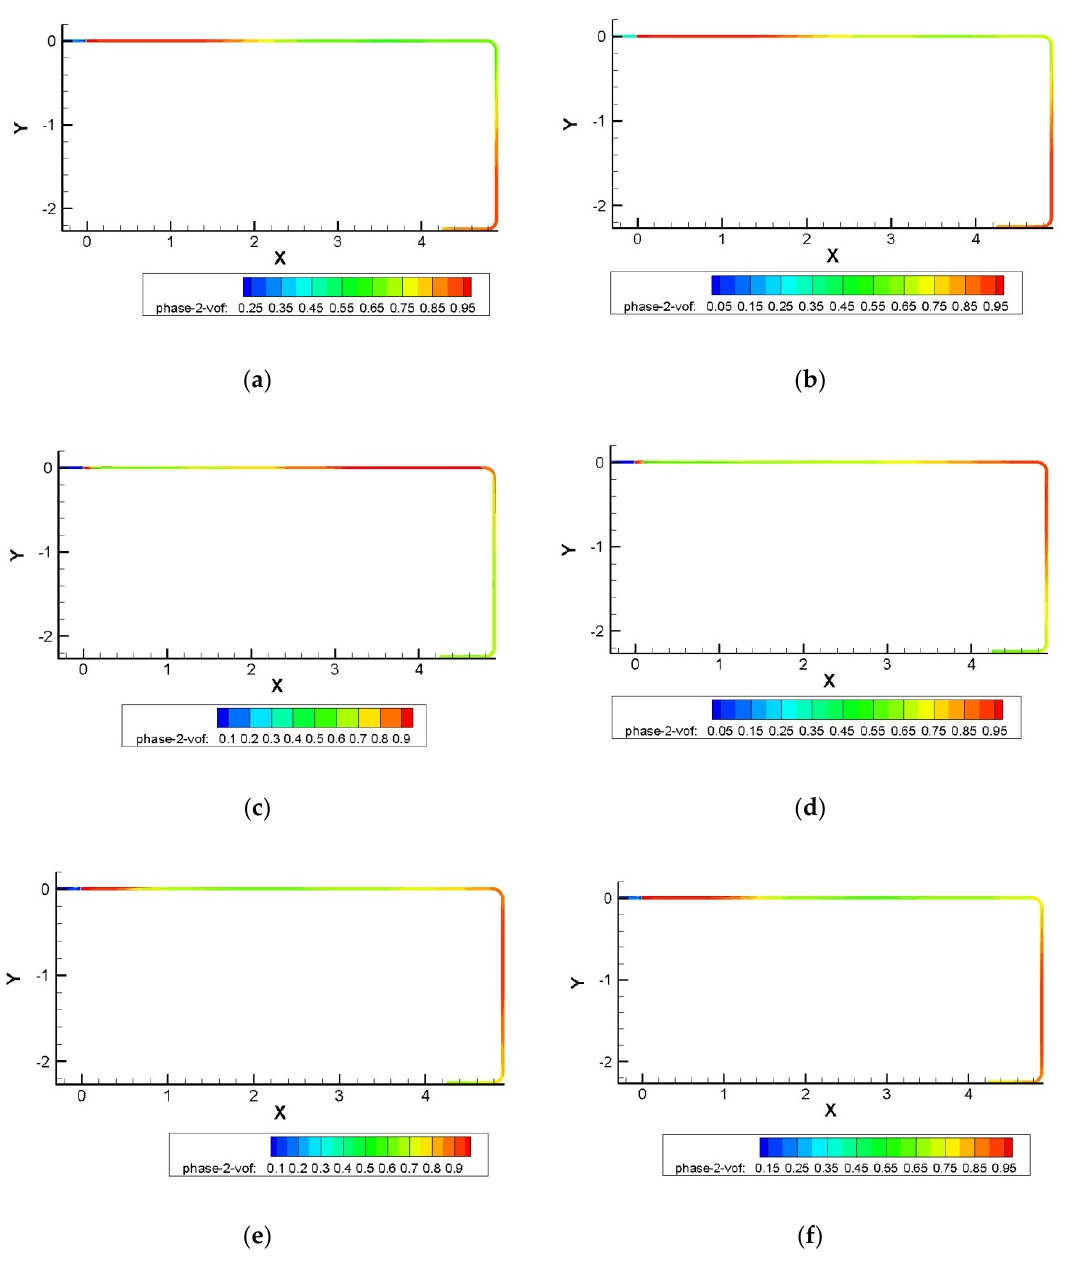
Figure 7. The water-phase volume ratio distribution of horizontal axis intersecting surface within a period: ( a ) t = 0; ( b ) t = 2 s; ( c ) t = 4 s; ( d ) t = 6 s; ( e ) t = 8 s; ( f ) t = 10 s.